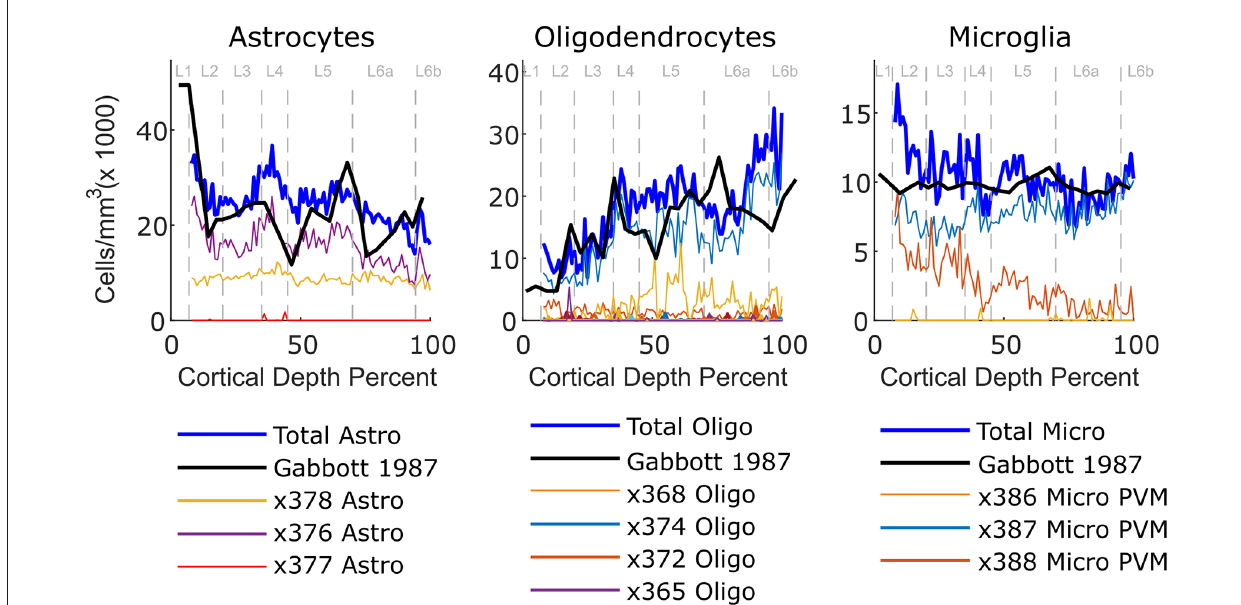
FIGURE5 Assignment of single cells to cortical positions based upon their transcriptomes for astrocytes, oligodendrocytes, and microglia. The thick dark blue shows the summed predicted traces, while the thinner colored traces are the subtypes of each predicted class. The density in layer 1 was quite high and likely artifactual, so is omitted in order to better show the features of other layers. The thick black traces in the top rows show experimental densities from Gabbott and Stewart (1987), for the rat. In all graphs, layer boundaries for L1, L2, L3, L4, L5, L6a, and L6b are indicated by the dashed gray